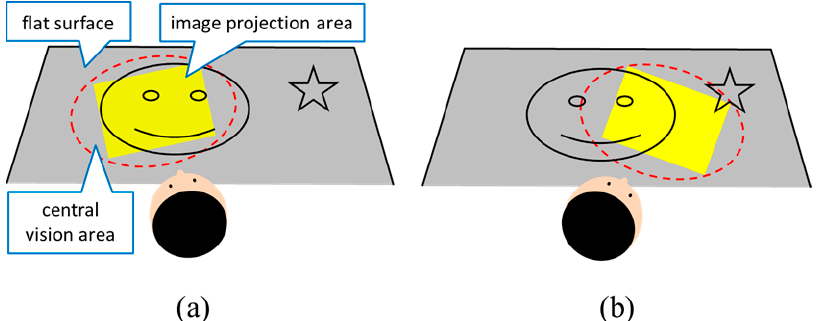
Figure 1. Concept of the proposed system. By using the head-mounted projector, images are always projected in front of the user in the direction of the user’s gaze. The image to be projected is changed according to the user’s head pose so as to fix the superimposed images on the surface.